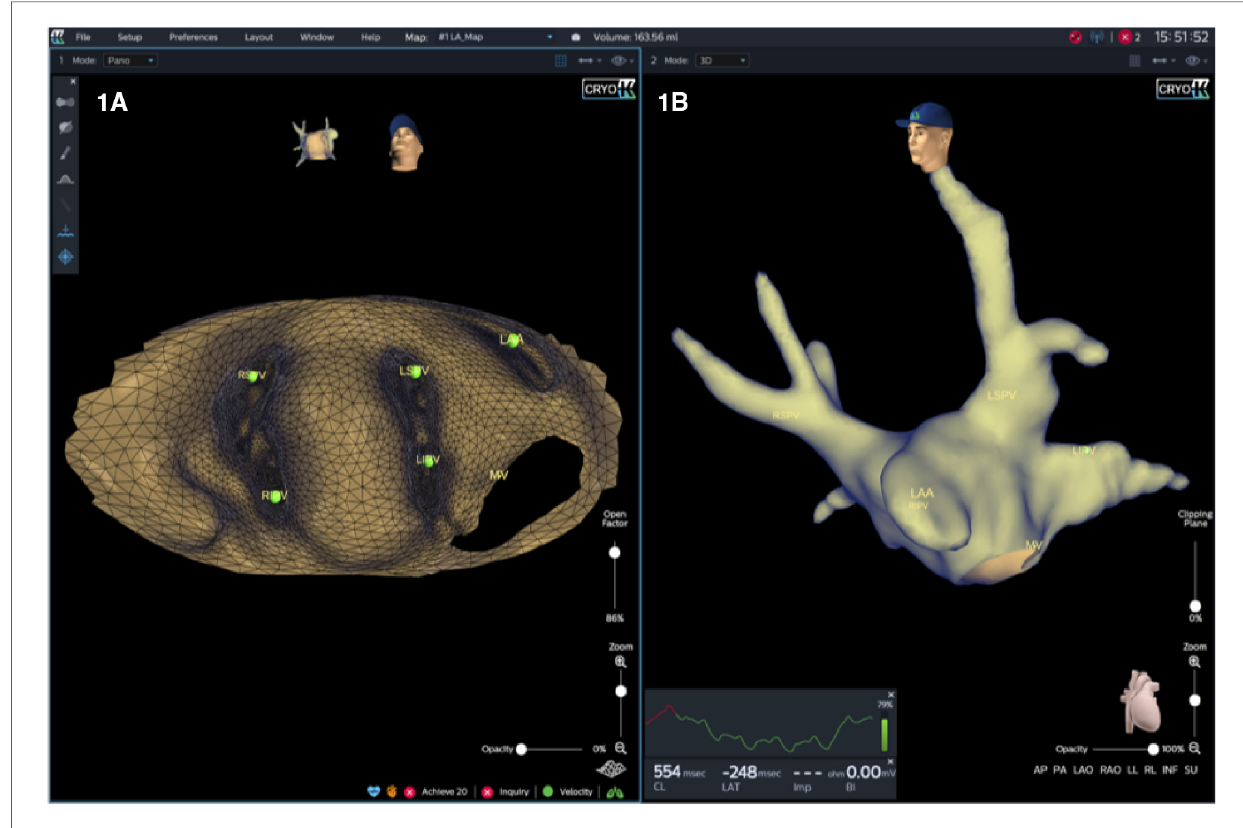
FIGURE 1 KODEX-EPD offers two options for the operator to visualize the cardiac anatomy. First, a 3D surface image, which provides a conventional shell of the heart chamber and may be rotated freely ( B ). Second, in an innovative approach, the heart may be opened virtually across the 3D surface and this fl attened 3D panoramic view ( “ PANO ” view) offers a visualization of the endocardial surface ( A